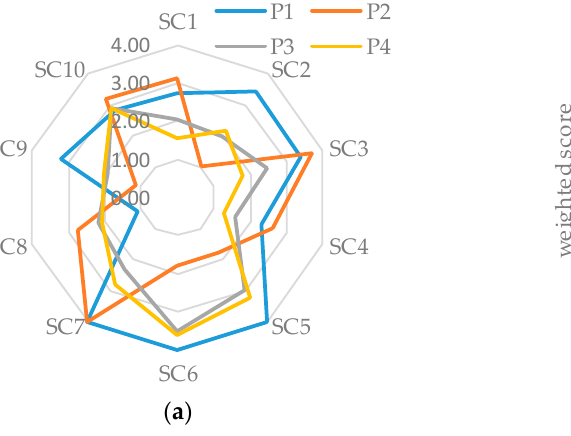
Figure 2. Weighted scores of all indicators. ( a ) Weighted scores of secondary indicators. ( b ) Weighted scores of primary and overall indicators.